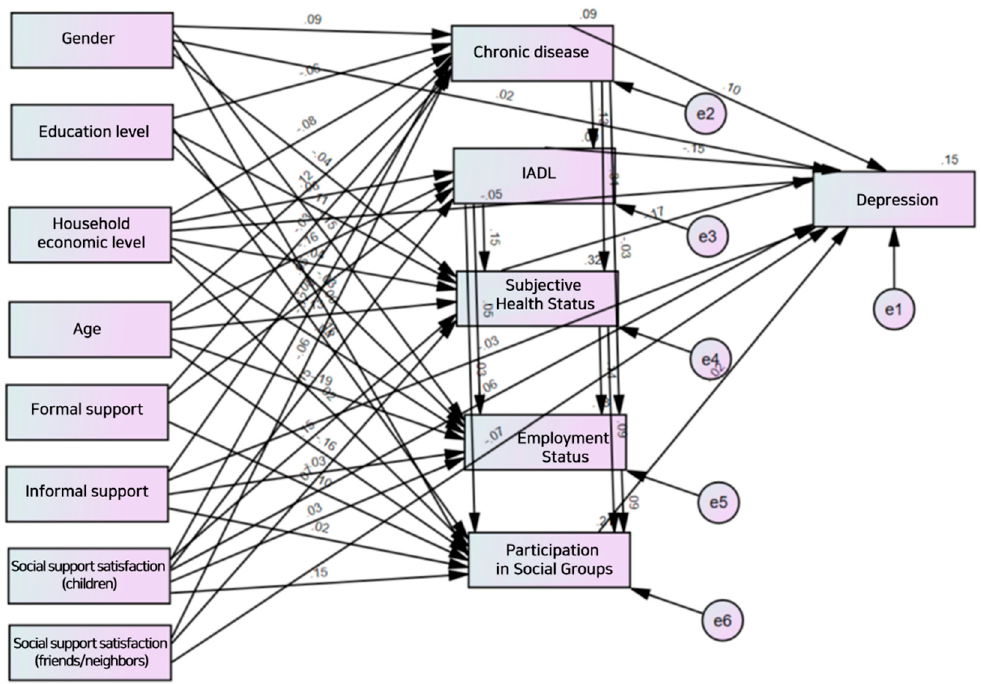
Figure 3. Standardization coe ffi cients of the predictive model.